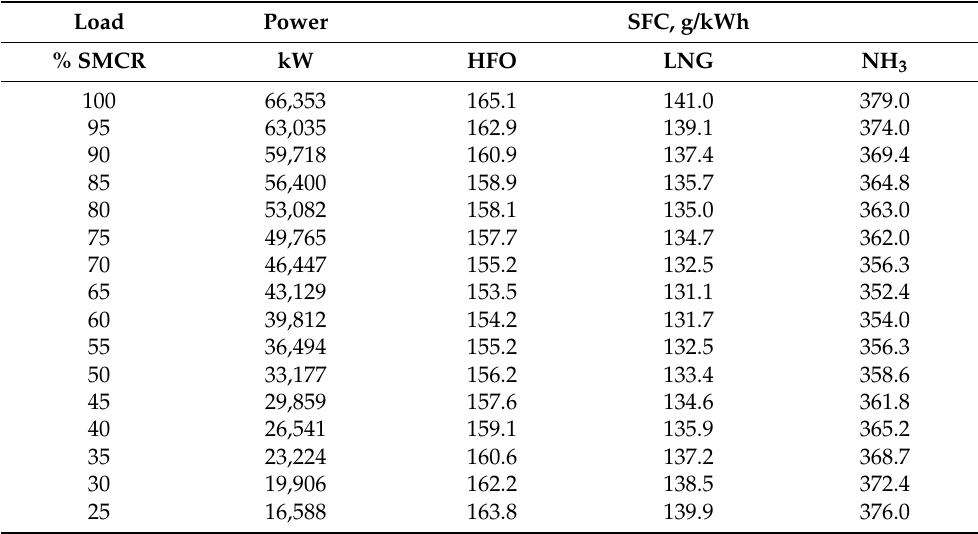
Table 4. Specific consumption of fuels [27].